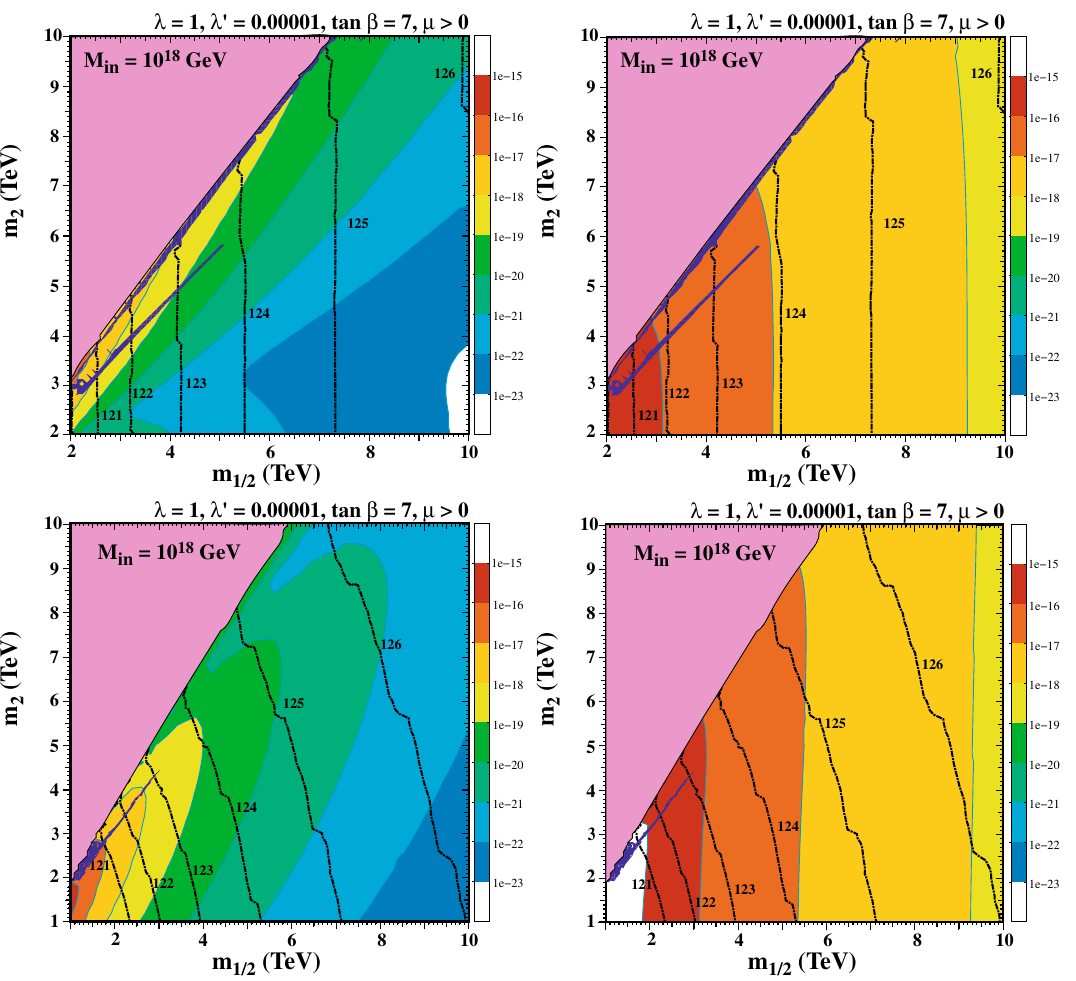
Fig. 11 AsinFig.6,showingvaluesofBR (μ → e γ) inthe ( m 1 / 2 , m 2 ) planes for the flavor choices A (left) and B (right) in model M5 (upper panels) and model M6 (lower panels) both with M in = 10 18 GeV,